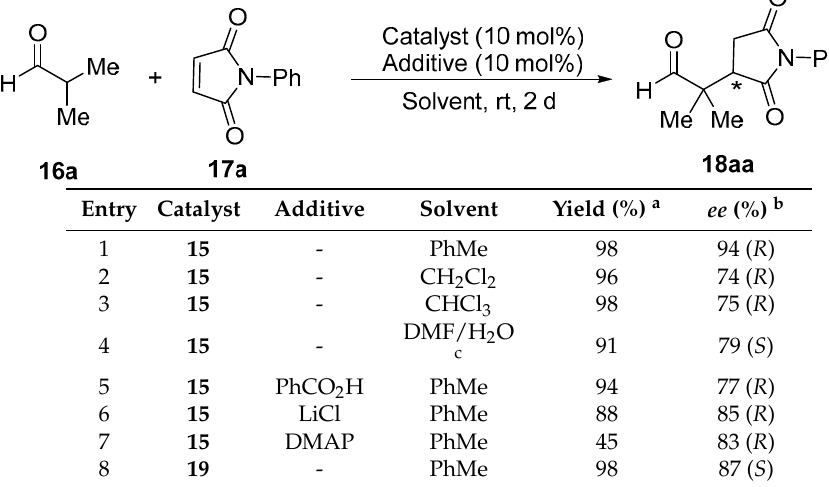
Table 1. Screening and optimization of the reaction conditions for the model enantioselective Michael addition.